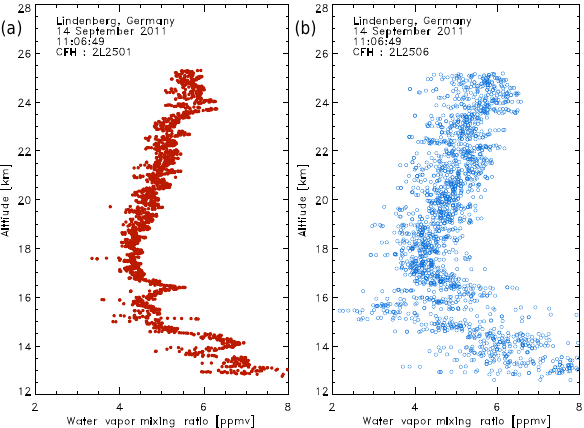
Figure 1. Simultaneous water vapor profiles using two CFH instru- ments, showing different controller